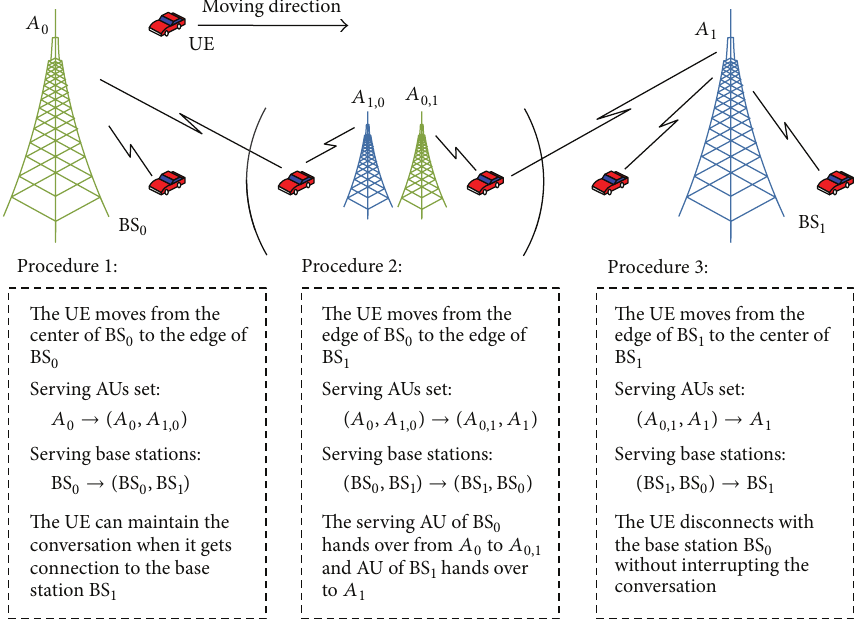
Figure 3: UE handover procedures in